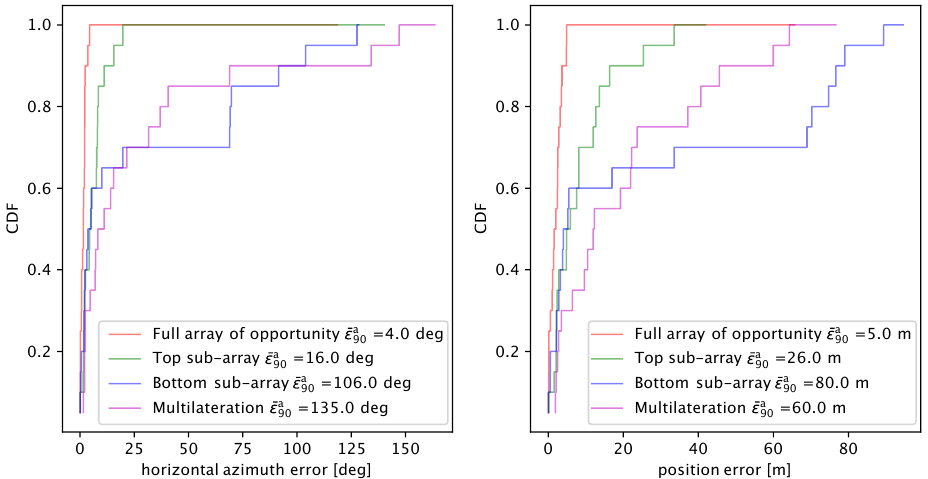
Figure 14. CDF of the azimuthal angle estimation error ( left ) and of the total location error ( right ) achieved in the lake experiment, showing the performance of our method as applied to different portions of the array of opportunity, as well as